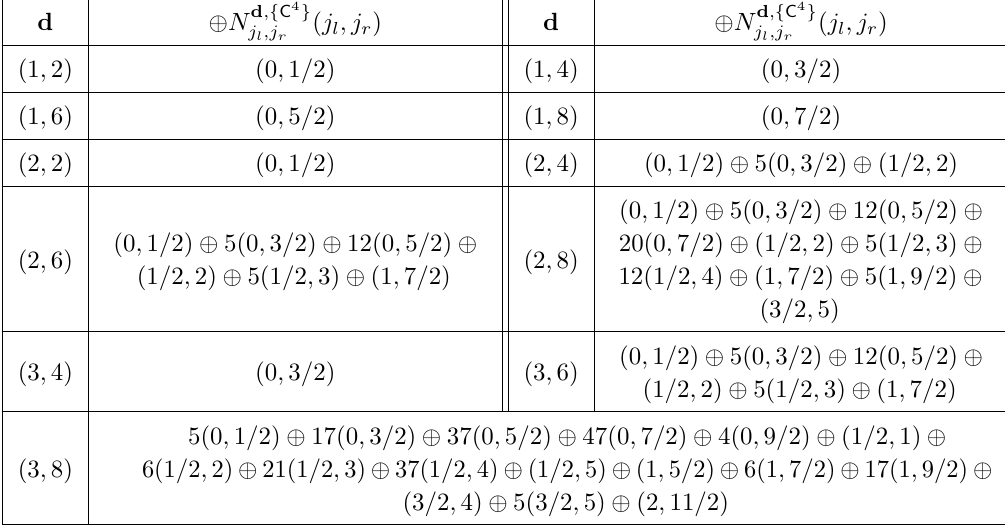
for the curve class d 1 m 0 + d 2 φ with d 1 ≤ 3 BPS , { C 4 }